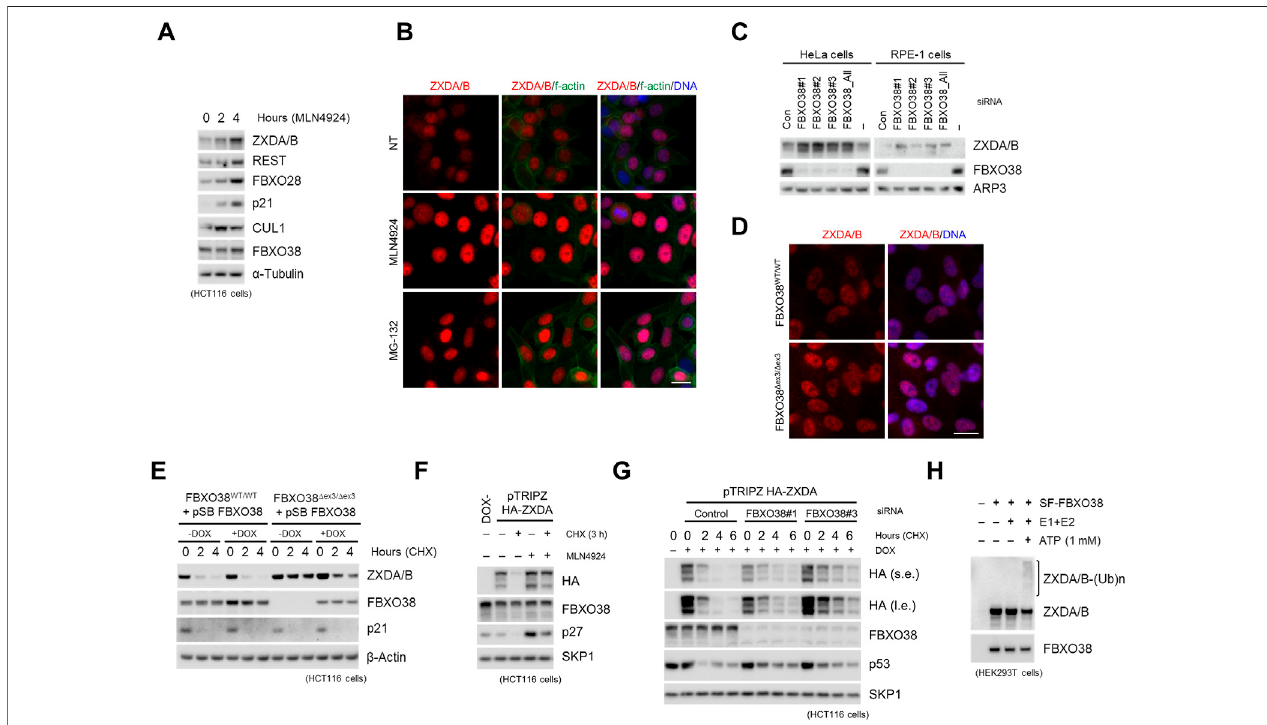
FIGURE 2 | FBXO38 mediates ubiquitination and controls the stability of ZXDA/B. (A) HCT116 cells were treated with MLN4924 for 2 and 4 h, lysed and immunoblotted as indicated (B) HeLa cells were grown on slides and treated with MLN4924 or MG-132 for 12 h where indicated. The cells were fi xed and immunostainedwithananti-ZXDA/Bantibody.DNAwasstainedwithDAPI,andf-actinwasvisualizedusingphalloidin.Scalebar,20 µm. (C) HeLaandRPE-1cellswere transfected with three different siRNAs targeting FBXO38, and whole-cell lysates were immunoblotted as indicated. Non-targeting siRNA (Con) or no siRNA were usedasnegativecontrols. (D) Wild-type(WT)orFBXO38knockoutRPE-1cells(FBXO38 Δ ex3/ Δ ex3 ;KO)weregrownonslides, fi xed,andimmunostainedwiththeZXDA/B antibody.DNAwasstainedwithDAPI.Scalebar,20 µm. (E) StrepII-FLAG-taggedFBXO38(SF-FBXO38)wasinduciblyexpressedinFBXO38WTandKOHCT116cells using the Sleeping Beauty Transposon System. Where indicated, the expression of FBXO38 was induced with doxycycline for 24 h. Cells were treated with cycloheximide (CHX) for the indicated time. Whole-cell lysates were immunoblotted as indicated. (F) HCT116 cells with doxycycline-inducible expression of HA-tagged ZXDAwere treated withdoxycycline for24 hand then treatedwith CHX for3 h. Whereindicated, cellswere pre-treated withMLN4924 for 3 h. Non-treatedcells (DOX-) wereusedasanegativecontrol.Whole-celllysateswereimmunoblottedasindicated. (G) HCT116cellswithdoxycycline-inducibleexpressionofHA-taggedZXDAwere transfected with two different siRNAs targeting FBXO38. Expression of ZXDA was induced by doxycycline 18 h after transfection. Cells were treated with CHX for the indicated time and collected 48 h after transfection. Whole-cell lysates were immunoblotted as indicated (H) SF-FBXO38 was overexpressed in HEK293T cells and isolatedusingStrep-Tactinresin.Eluatewassubjectedto invitro ubiquitinationinthepresenceofE1andE2enzymesorE1,E2,andATP.Anemptyvector(EV)wasused as a negative control. ZXDA/B antibody was used to detect polyubiquitinated forms of co-puri fi ed endogenous ZXDA/B proteins.